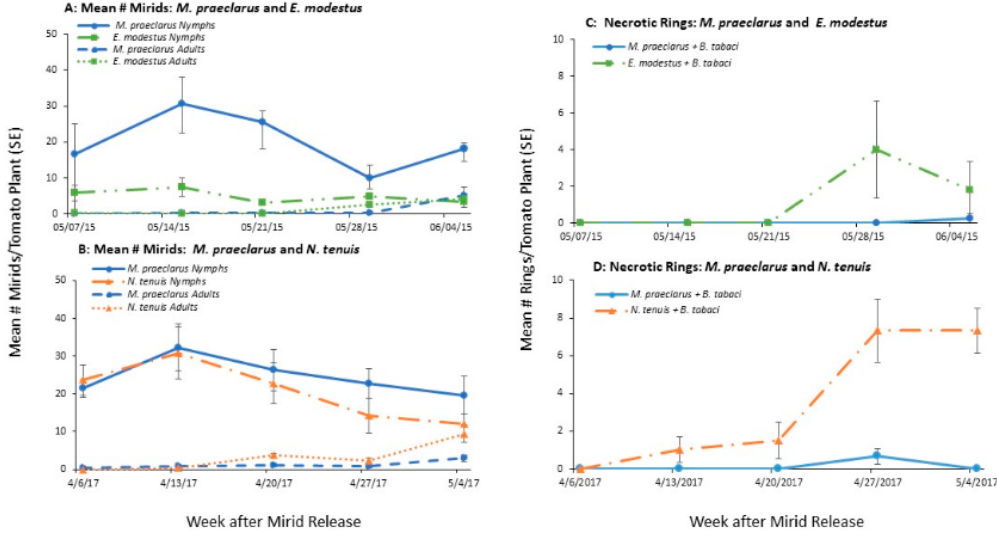
Figure 2. Mean ( ± SE) number adult and nymph mirids and the damaged caused by the mirids (necrotic rings) on tomato plants inoculated with whiteflies ( Bemisia tabaci ) in two five week field cage studies. Experiment 1 ( A , C ) compared mirid population growth and damage of Macrolophus praeclarus and Engytatus modestus . Experiment 2 ( B , D ) compares mirid population growth and damage of Macrolophus praeclarus and Nesidiocoris tenuis .